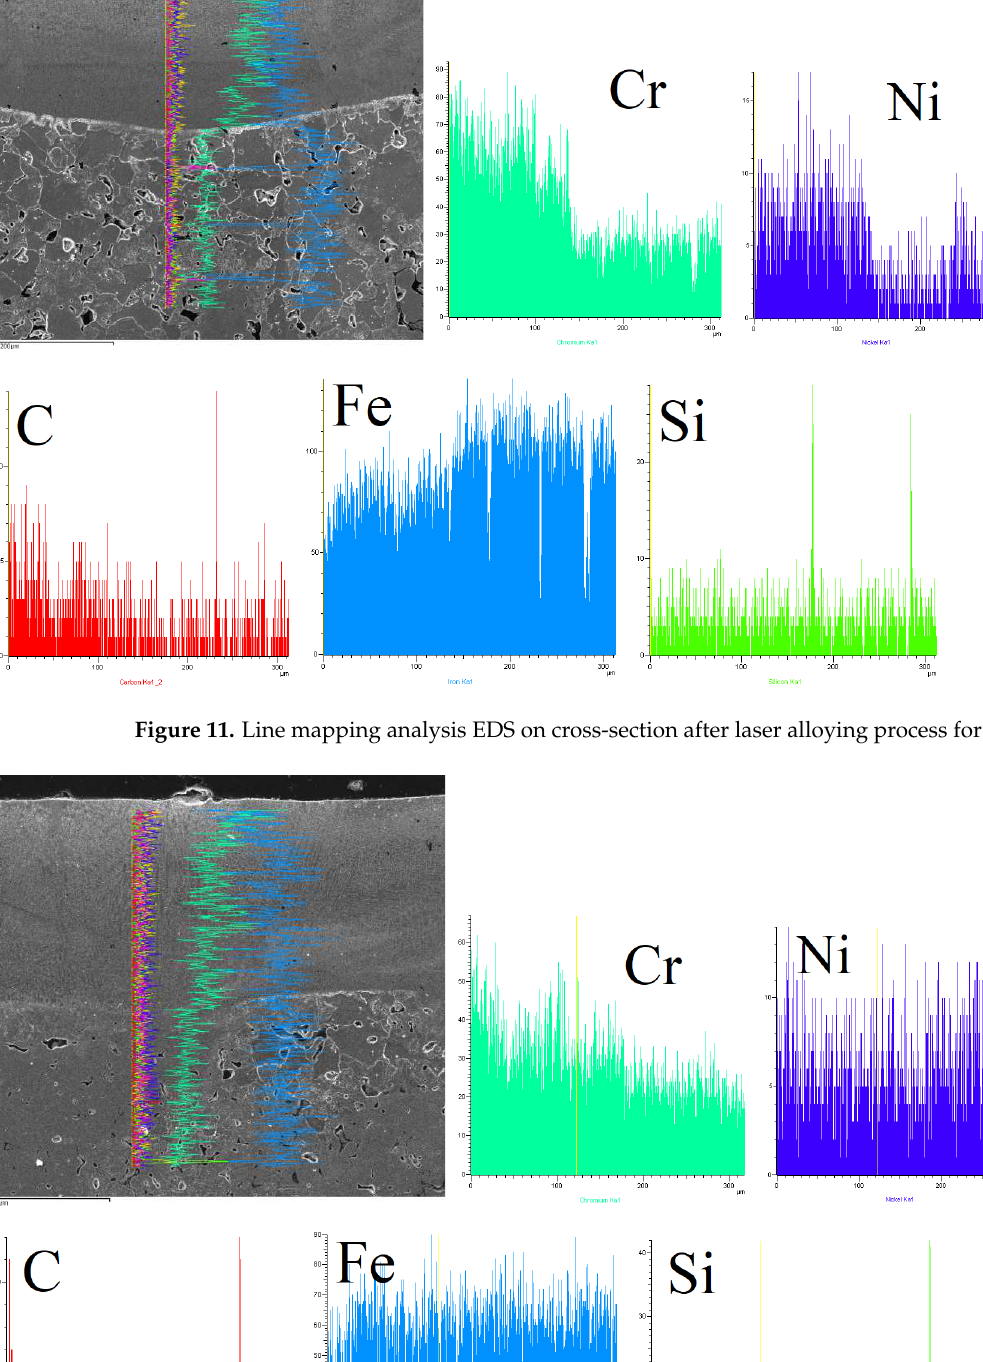
Figure 13. Line mapping analysis EDS on cross-section after laser alloying process for sample 3. To determine the phase composition on the laser-alloyed surface layer, an X-ray phase analysis was performed. Results of the identification of the phase composition for samples 1, 2, and 3 are presented in Figure 14. The phase analysis for individual specimens showed the austenitic and ferritic phases with the content proportional to the powders used.